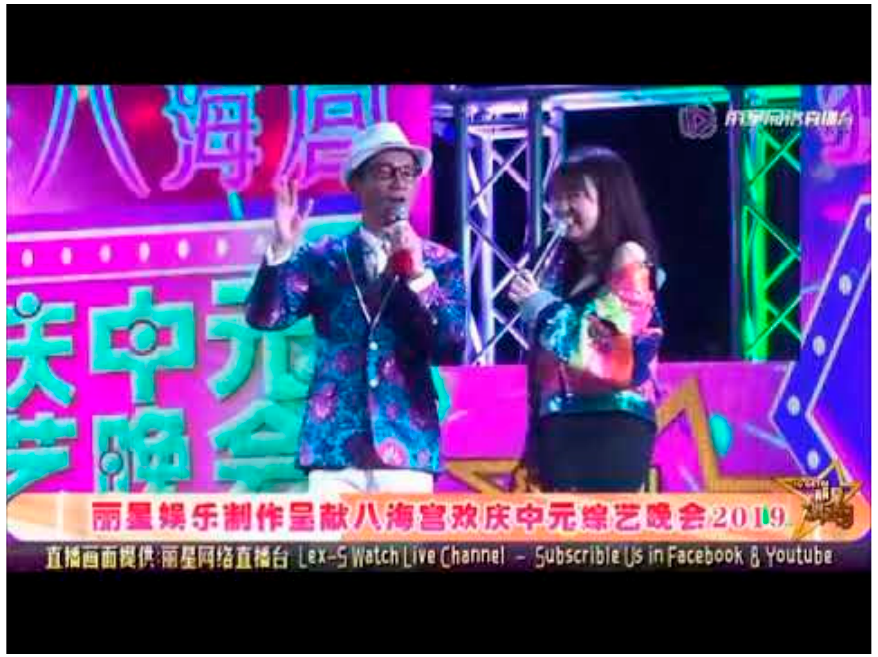
Figure 6. A live Getai performance on YouTube (Just Music 只是宣傳 2019). The title of the show is LEX(S) Entertainment Production, The Hungry Ghost festival at Ba Hai Gong 2019.